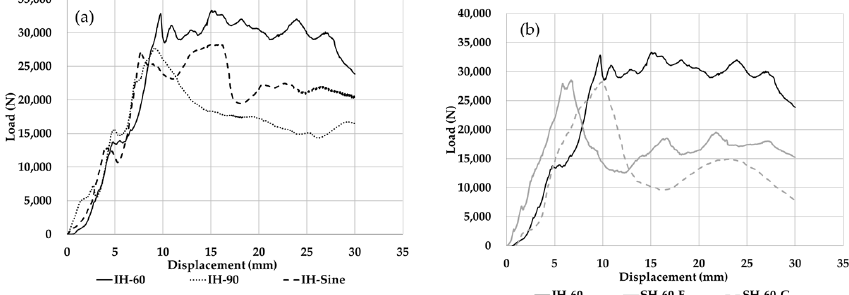
Figure 6. The axial crushing load-displacement response for ( a ) webs having different frontal profiles, and ( b ) webs having different stacking sequences.